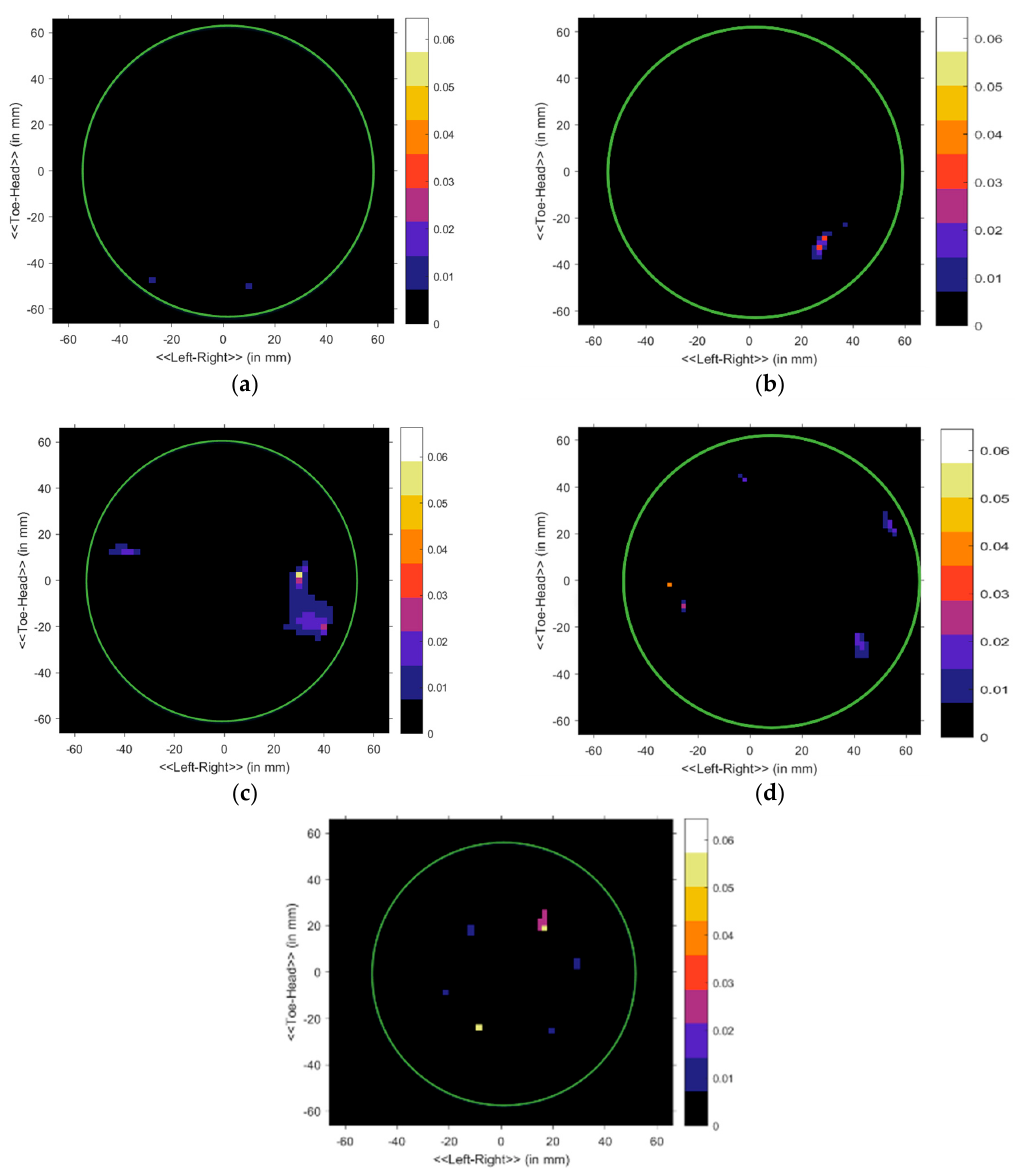
Figure 15. Imaging results. Homogenous: ( a ) no tumor, ( b ) 1 tumor, ( c ) 2 tumors, ( d ) 4 tumors; and heterogenous: ( e ) 2 tumors. Table 4. Comparison of the existing imaging system with proposed system.